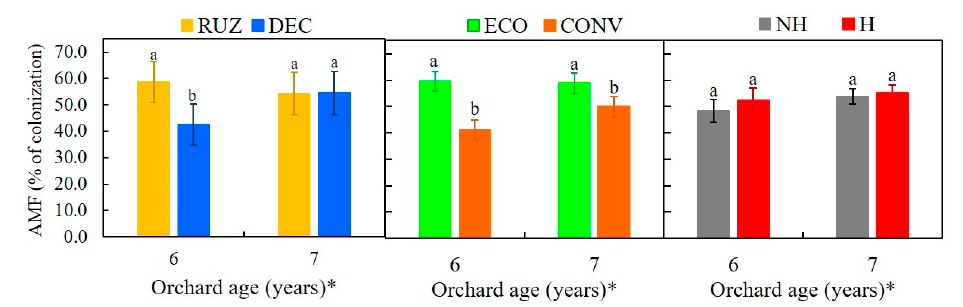
Figure 6. Percentage of colonization by arbuscular mycorrhizae fungal (AMF), tested with different cover crops, mowers, and the use of glyphosate (Mogi Mirim, São Paulo, 2016–2017). Legend: RUZ = Urochloa ruziziensis , DEC = U. decumbens , ECO = ecological mower, CONV = conventional mower, H = glyphosate herbicide (1080 g ae. ha − 1 ), NH = no herbicide. The significant di ff erence was accounted for by the Tukey test ( p < 0.05), and the error bars represent the minimal significant di ff erence. * Orchard